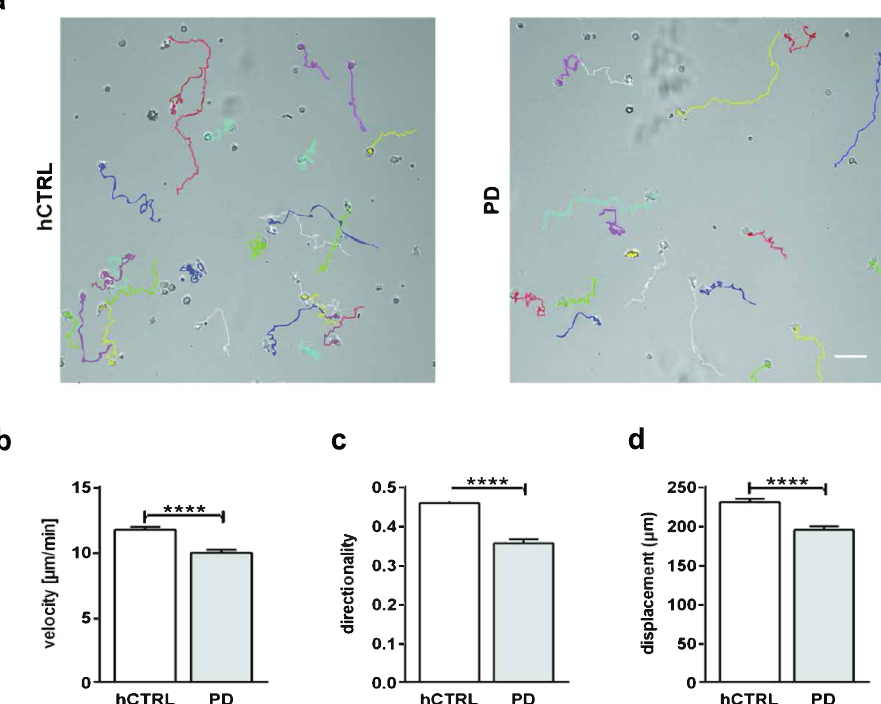
Fig. 2 Primary CD4 + T cells derived from PD patients are slower and less persistent than healthy controls. Primary CD4 + T cells derived from nine PD patients and nine age/sex-matched healthy subjects were cultured for 7 days. The cells were transferred to 10 μ g/mL human ICAM-1 coated µ-slides and incubated at 37 °C, 5% CO 2 for 45 min. Live imaging was performed while cells were migrating on ICAM-1 coated 2D surface. Both PD and control CD4 + T cells were recorded at 10x magni fi cation for 20 min and subsequently manually tracked. a Representative snapshots with cell tracks for both PD and control (arbitrary colors); scale bar, 50 μ m. b – d Quanti fi cation of velocity ( b ), directionality ( c ), and displacement ( d ) of all tracked cells. The data were obtained from nine independent experiments (345 PD cells and 293 healthy control cells were tracked). Represented data are means ± SEM. Signi fi cance was assessed by Mann – Whitney test. **** p <